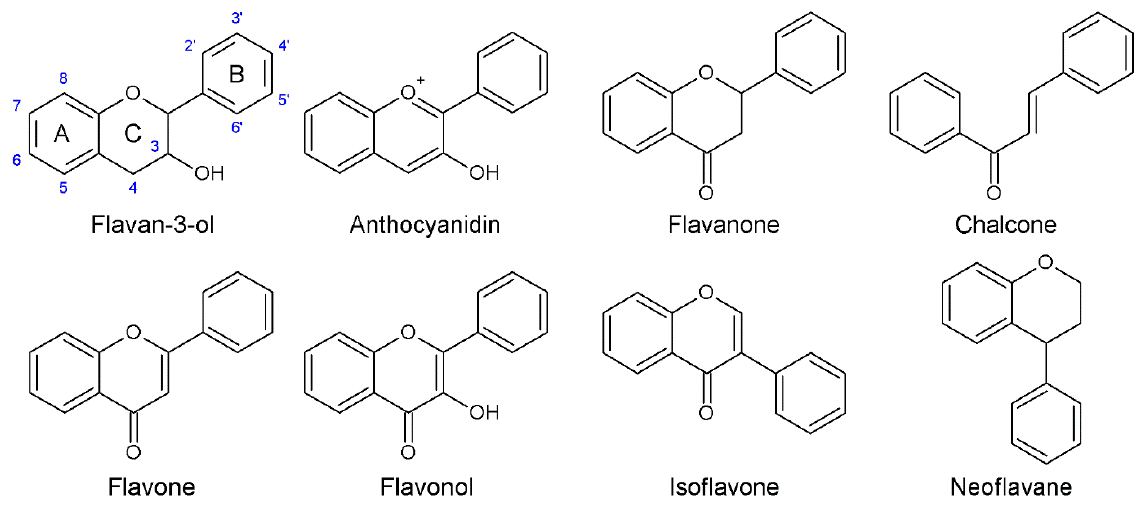
Figure 6. Structures of flavonoids.